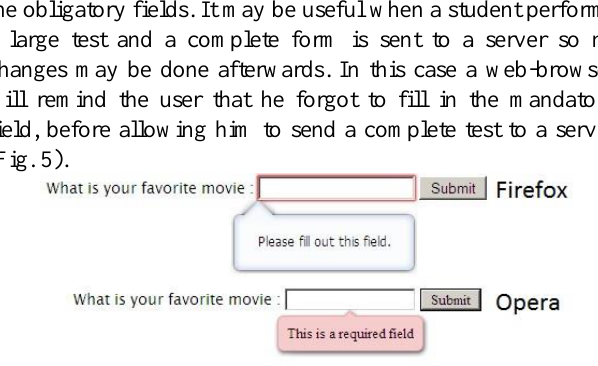
Fig. 5. Feedback to a user who forgot to fill in an obligatory field.